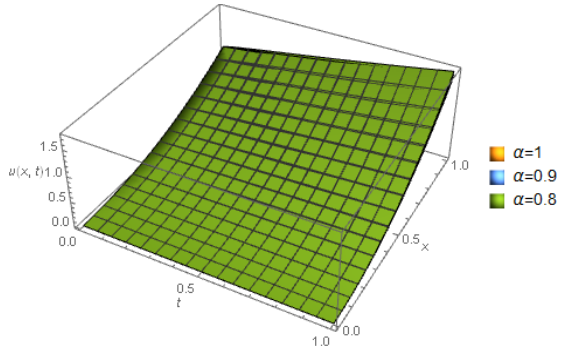
Figure 3:3D Solutions of example1 with di⁄erent Figure 8. 3D Solutions of Example 2 with different values of α . values of (cid:11)